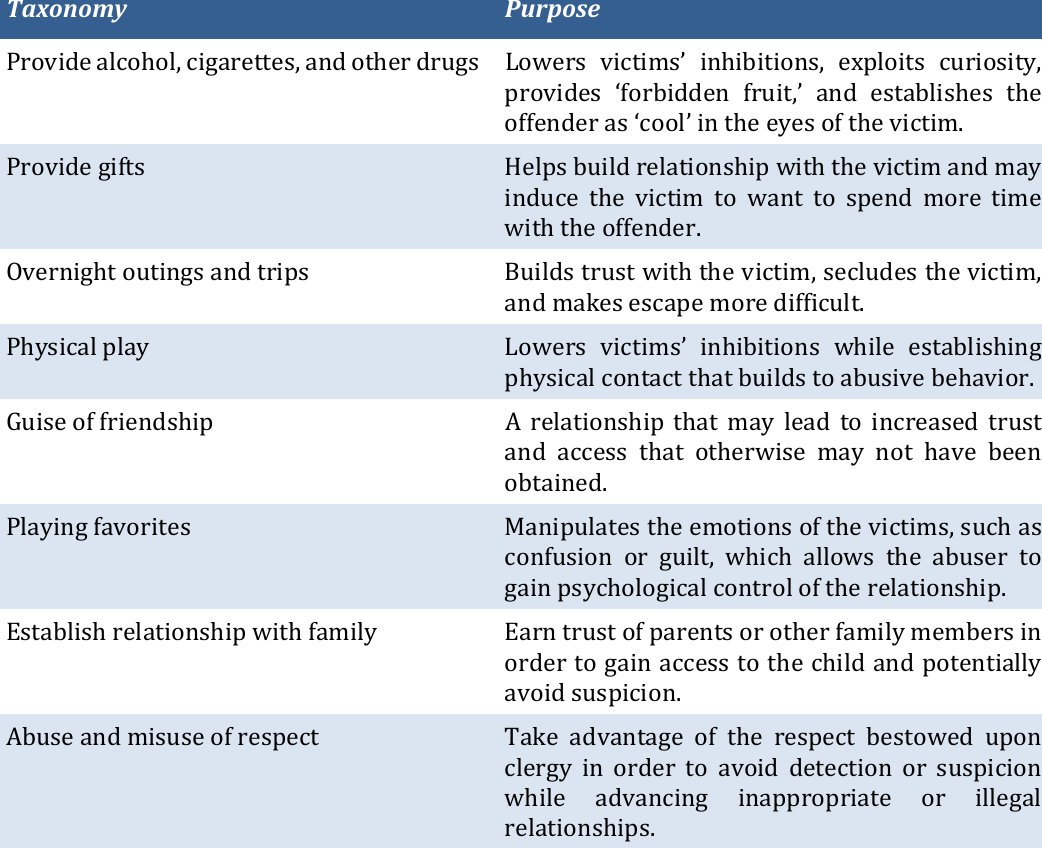
Table 1: Proposed taxonomy of priest sexual grooming behaviors